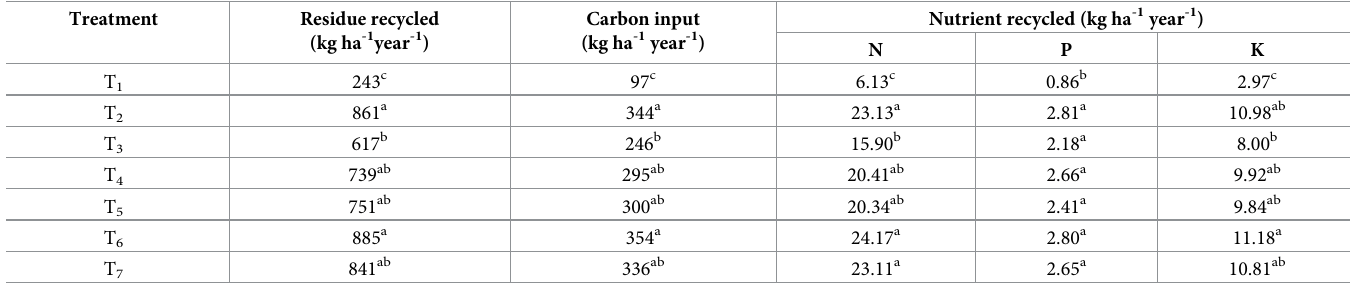
Table 7. Carbon and nutrient addition through residue recycling in soybean.